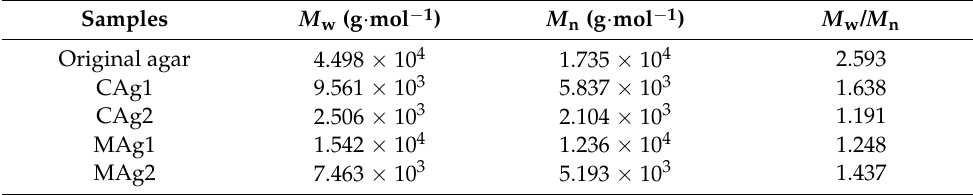
Table 4. Effect of the synthetic method on the molecular weight of carboxymethyl agar samples having different DS